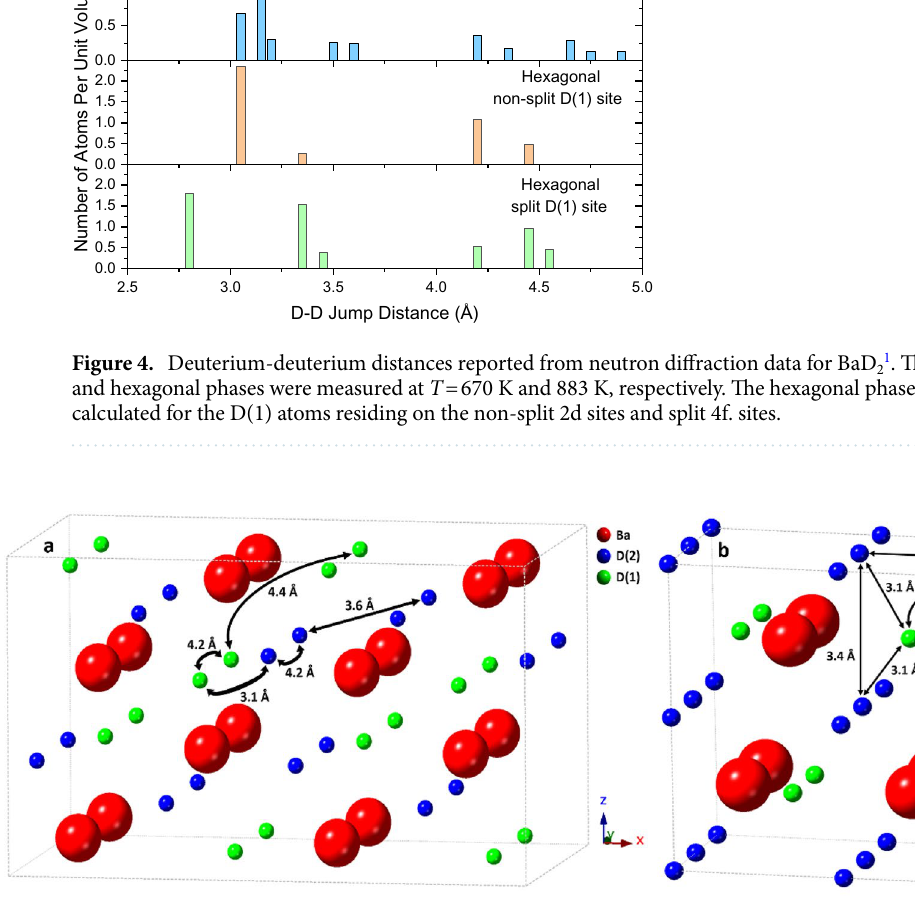
Figure 5. Crystal structures and potential diffusion pathways in BaD 2 for the ( a ) low temperature orthorhombic phase at 670 K and the ( b ) high temperature hexagonal phase at 883 K. Additional jump lengths are also shown for